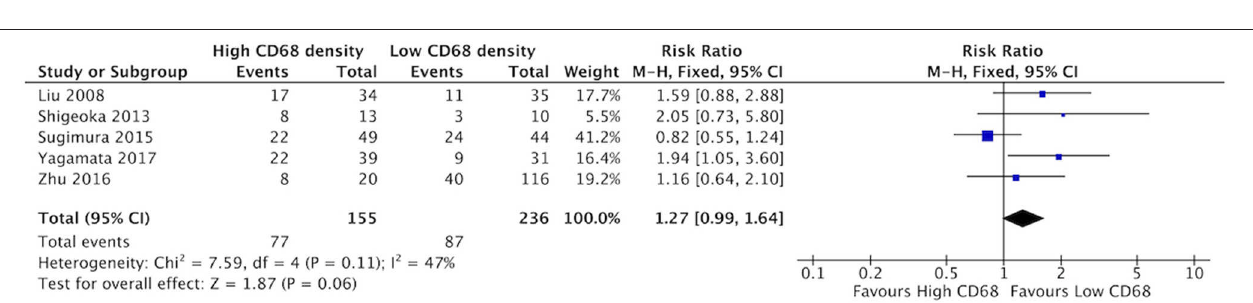
FIGURE 9 | High CD163 + TAM density is associated with higher rates of lymphatic invasion.